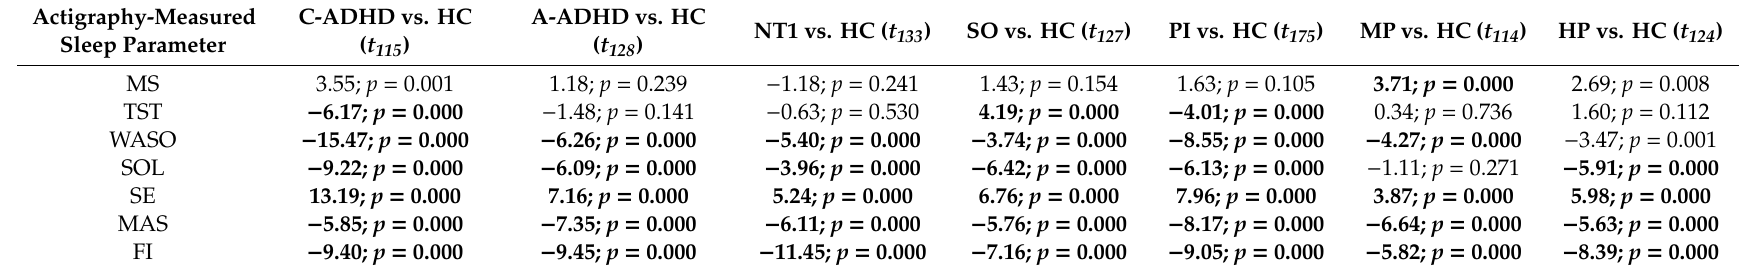
Table 2. Pair comparisons between healthy controls (HC) and patients from several clinical